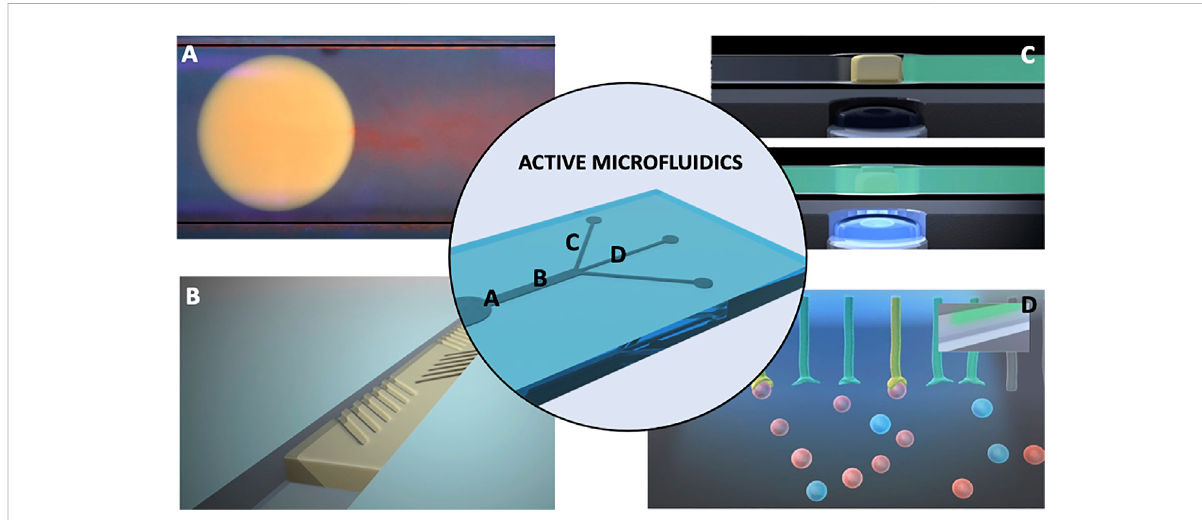
Graphical depiction ofthe active fl uidics concept showing four functionalities that could beincorporated in to a single micro fl uidic devices: (A) energy-freetransportofmicrodropletstravellingbychemotaxisintheleftdirectionshowingaredplumeofexpelledmaterialfromtherightside;The dropletisbasedontheionicliquidtrihexyl(tetradecyl)phosphoniumchloridepoweredbychemicalgradients,asdemonstratedbyFrancisetal.,2015; Image produced by Annael Sort-Montenegro and the authors, unpublished work; (B) Illustration showing on-demand generation of micro- topologies for control of mixing behaviour — envisioned angled features emerge from and converge into the surface under external photostimulation; such structures have been demonstrated by Stumpel et al., 2014; ter Schiphorst et al., 2018); (C) photo-responsive hydrogel microvalvesshowingthatwhentheblueLEDlightisoff,themicro-valve(depictedinyellow),stopstheliquid fl ow(green),whileswitchingthelighton causes a shrinking of the photo-responsive hydrogel valve and the liquid fl ows through the channel; such photo-responsive microvalves have been demonstrated by Delaney et al., 2017; Saez et al., 2018; (D) Active channel walls that can be photoactivated to selectively bind and report chemical species presented in the fl ow (depicted here by a change in colour). The bound species can be subsequently released via removal of the photostimulation, which reverts the surface to the inactive non-binding form; such photo-activated coatings for metal ion accumulation, detection and release are described by Dunne et al., 2018. All images come from research projects led/supervised by the